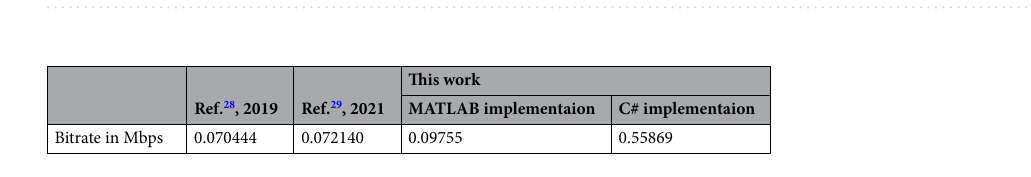
Table 7. Comparison of bitrates in this work and in other PRNGs over